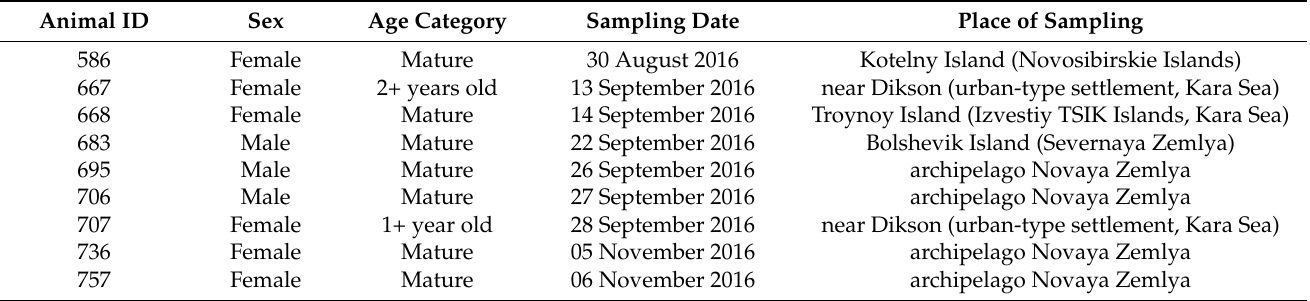
Figure 2. Presence of antibodies to analyzed pathogens in polar bear serum. Table 1. General information on polar bears sampled in 2016 (ID numbers correspond to Figure